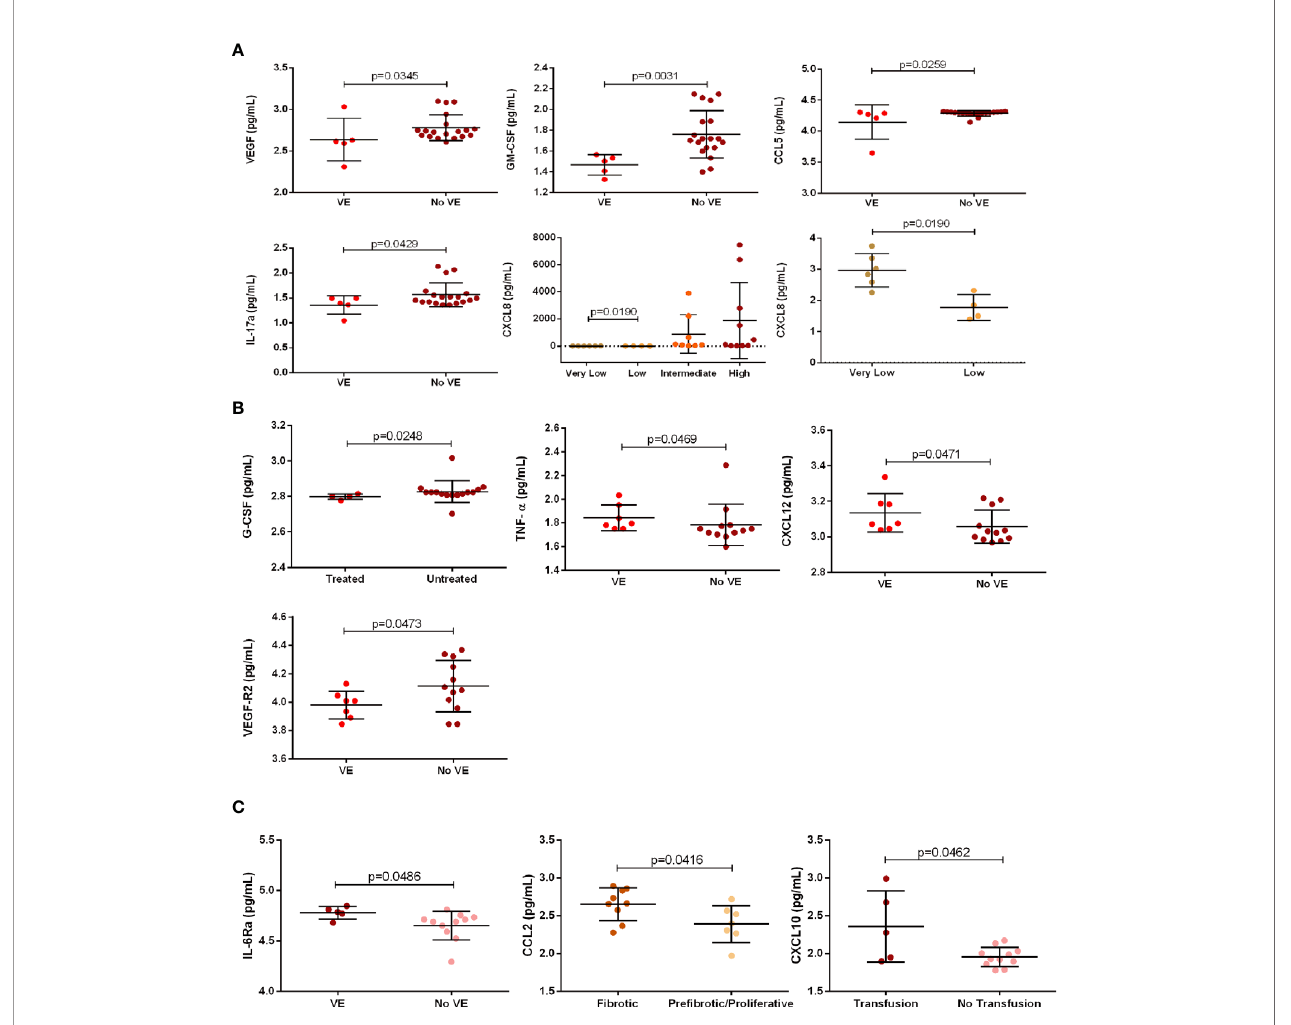
FIGURE 4 | Association between clinical parameters of patients with essential thrombocythemia (ET, n = 28), polycythemia vera (PV, n = 19), and primary myelo fi brosis (PMF, n = 16) and soluble mediator levels. (A) ET patients: association between VEGF, GM-CSF, CCL5, and IL-17 levels and the presence (n = 5) or absence (n = 19) of VE; and CXCL8 levels and risk-strati fi cation in very low (n = 6), low (n = 4), intermediate (n = 8) and high (n = 10) risk. (B) PV patients: association between G-CSF levels and administration (n = 4) or not (n = 15) of drug treatment; and association between TNF- a , CXCL12, and VEGF-R2 levels and the presence (n = 7) or absence (n = 12) of VE. (C) PMF patients: association between IL-6Ra levels and the presence (n = 5) or absence (n = 11) of VE; association between CCL2 levels and fi brotic disease (n = 9) or pre- fi brotic/proliferative (n = 7) stage; and association between CXCL10 levels and transfusion dependency (n = 5) or no transfusion necessity (n =